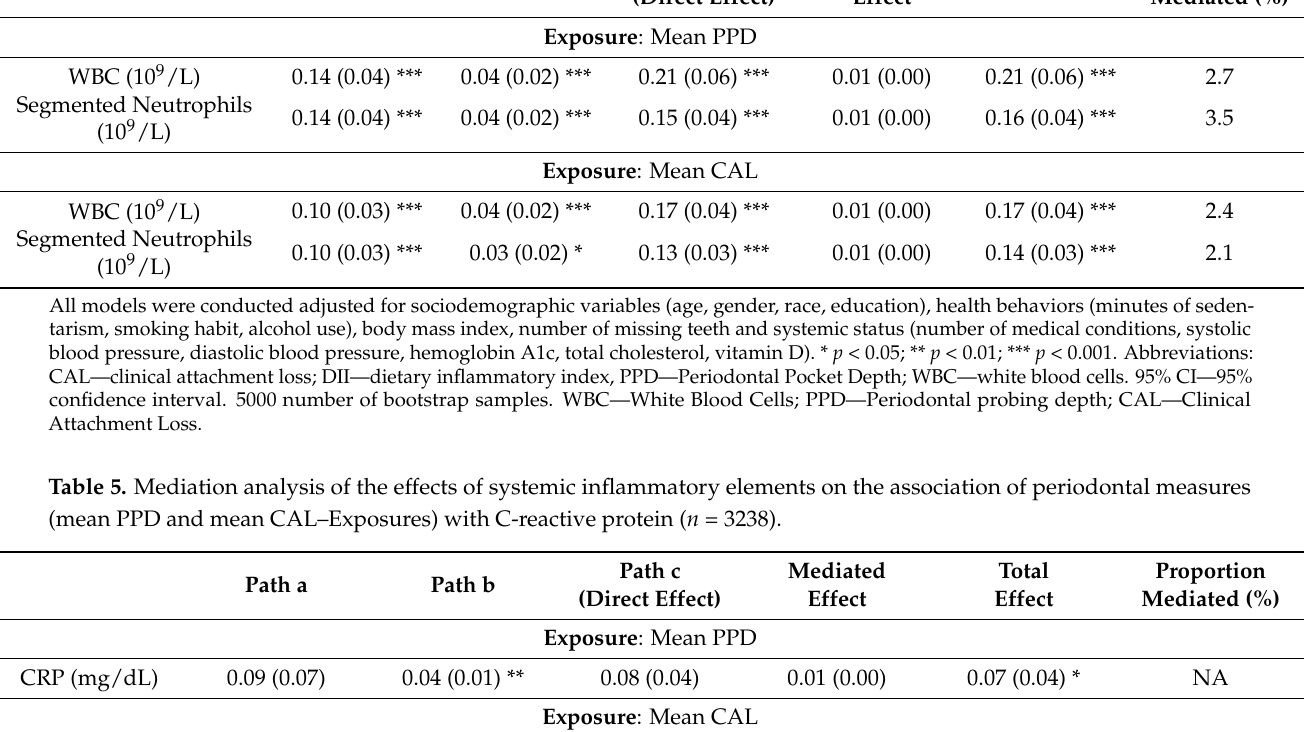
Table 4. Mediation analysis of the effects of systemic inflammatory elements on the association of periodontal measures (mean PPD and mean CAL—Exposures) with white blood cells and segmented neutrophils ( n = 10,178). Path c Path a Path b